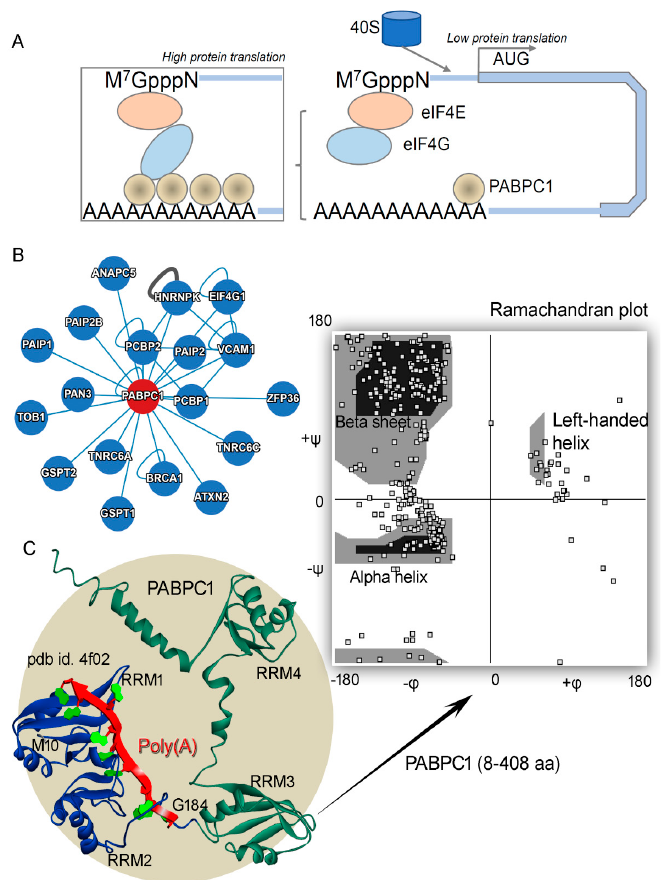
Figure 1. The poly(A)-binding protein cytoplasmic 1 (PAB1 or PABPC1) protein. ( A ) The conforma- tional switch of eIF4G (eukaryotic translation initiation factor 4 G) gene depends on the PAB1 expression; i.e., in normal cells having low PAB1 expression, binding of eIF4G-PAB1 is lacking, whereas in cancer cells having high PAB1 expression, binding is induced between these proteins [9]. ( B ) The PAB1 protein network map retrieved from the Interactome database [10]. ( C ) Crystal structure of PAB1 (RRM1–2 domains; RNA recognition motifs) with the poly(A) mRNA (pdb id.: 4f02 [2] in blue; M10-G184 amino acids) superimposed with the modeled PAB1 tertiary structure (RRM1-4 domains; in green). The modeled PAB1 contains the following RNA recognition motifs domains: RRM1 (11–89 aa), RRM2 (99–175 aa), RRM3 (181–268 aa), and RRM4 (294–370 aa). The right panel rep- resents the “Ramachandran plot” describing different secondary structures for the modeled PABPC1 structure, generated using the VMD (Visual Molecular Dynamics tool)